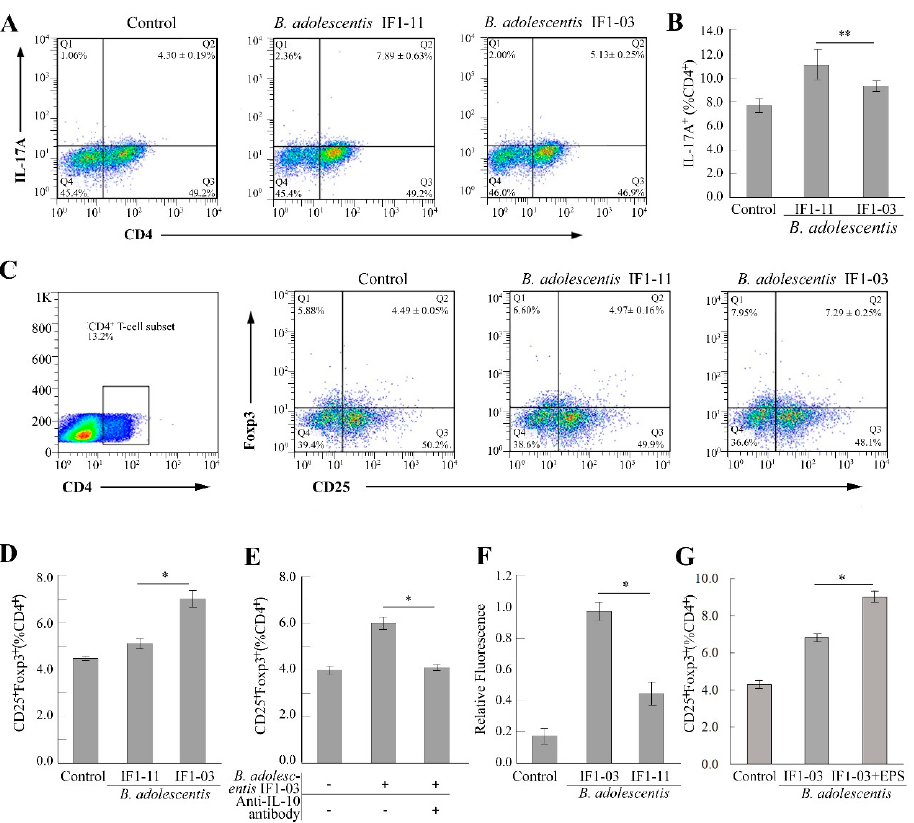
Figure 2. Effect of two B. adolescentis strains on differentiation and proliferation of Th17/Treg cells in coculture with splenocytes. Splenocytes isolated from BALB/c mice were stimulated with B. adolescentis IF1-11, B. adolescentis IF1-03 or left untreated (control) for 72 h. ( A ) Representative flow cytometric dot plot and ( B ) proportion of Th17 cells (CD4 + IL-17A + ) in spleen lymphocytes. ( C ) Representative flow cytometric dot plot and proportion of Treg cells (CD4+CD25+Foxp3+) to CD4+ T cells. SSC-H (side scatter-height) the basic parameter indicating cell internal complexity, FL2-H (Foxp3, PE), FL3-H (CD4, PerCp—Cy5.5), and FL4-H (CD25, APC) emitted fluorescence signal